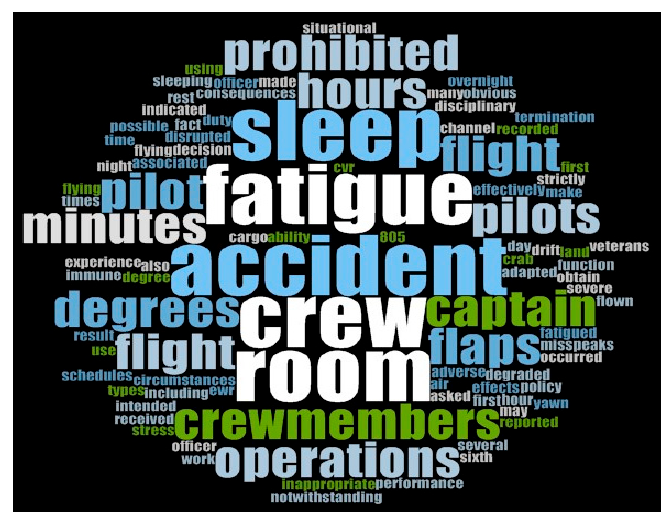
Figure 12. Tag cloud for fatigue as a contributing factor.